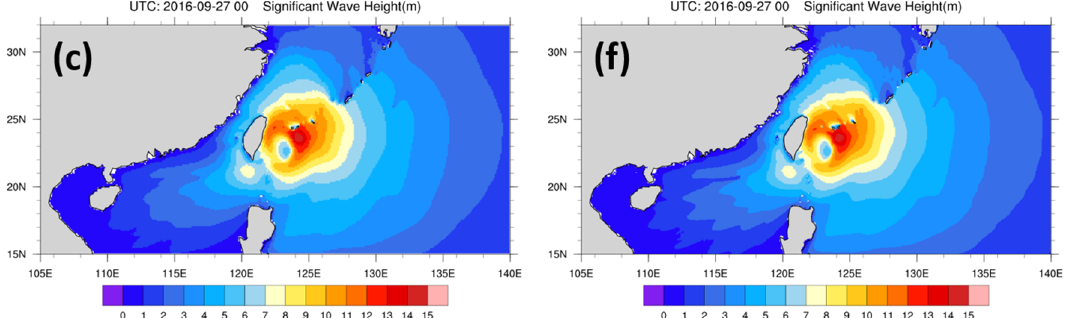
Figure 14. Spatial distribution of significant wave heights driven by the CFSV2 using the WW3 model with 0.10 deg ( a – c ) and 0.05 deg grid resolutions for Typhoons Meranti ( a , d ), Malakas ( b , e ), and Megi ( c , f ).